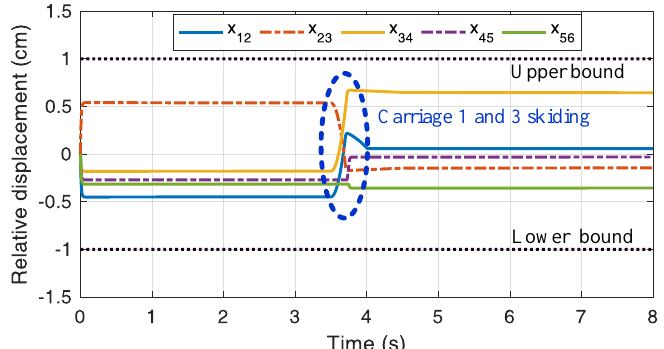
Figure 8. Relative displacement curve of each carriage with the proposed consensus braking controller in case 2.